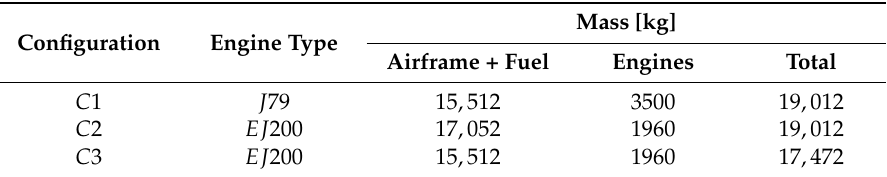
Table 4. Specifications of the examined configurations.